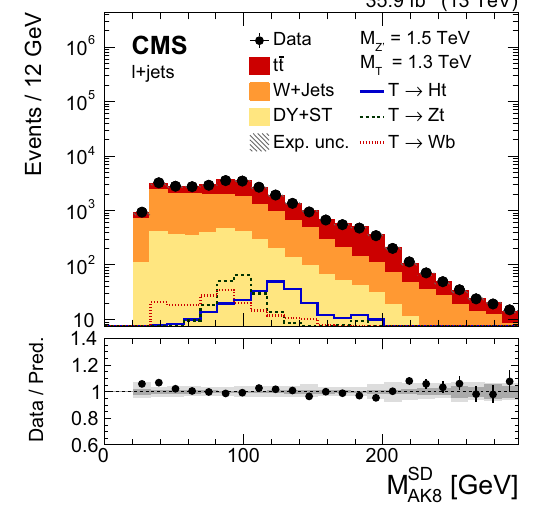
Fig. 2 Distribution of the soft drop mass of jets as reconstructed with the anti- k T jet algorithm with R = 0 . 8 after the event selection. Events are shown in the combined lepton + jets channel, with contributions fromdata,simulatedsignalsamples,andthesimulatedSMbackgrounds without corrections from the fit to data (explained in Sect. 6). The expected signal distribution from various T decay modes is shown for the example mass configuration M Z (cid:3) = 1 . 5TeV and M T = 1 . 3TeV with a nominal cross section σ( Z (cid:3) → tT ) of 1pb. The lower panel shows the ratio of data to predicted background. Here the darker grey band indicates the statistical uncertainty, whilst the lighter grey band shows the combined statistical and systematic uncertainty